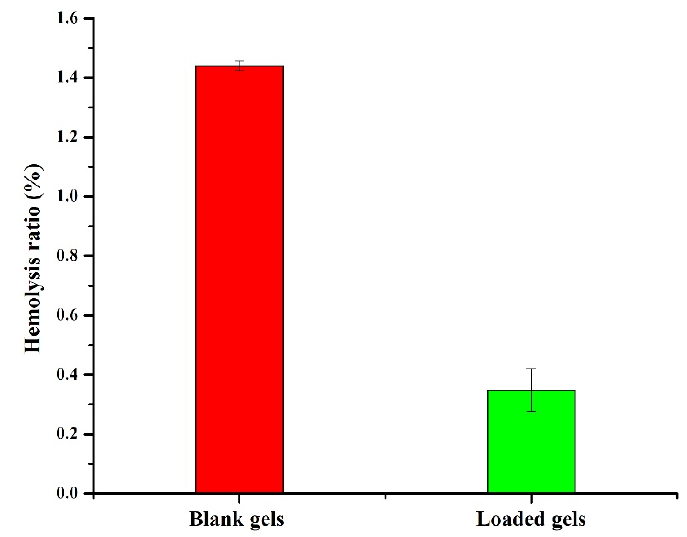
Figure 10. Hemocompatibility study of blank and drug-loaded hydrogels